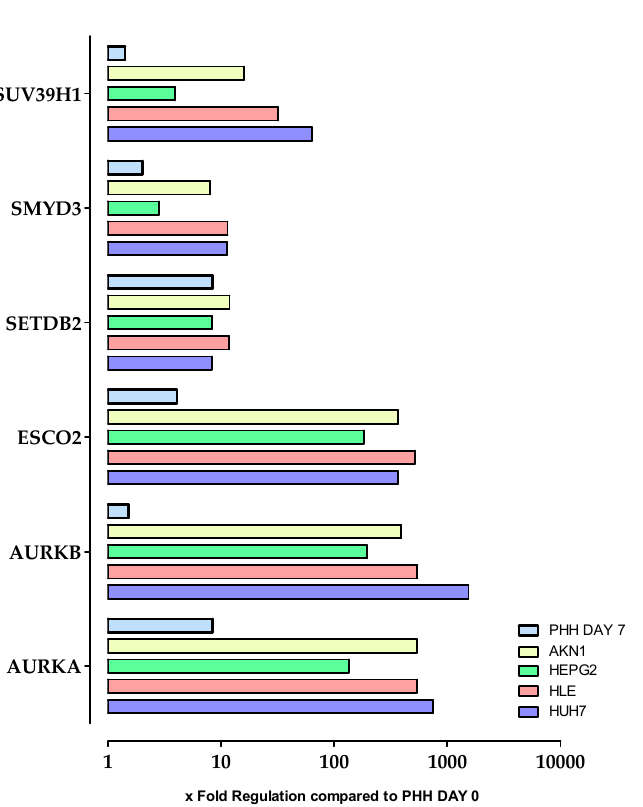
Figure 7. Chromatin modifying enzymes which are dramatically de-regulated in all tested cell lines and also de-regulated during primary human hepatocyte (PHH) de-differentiation in culture. Genes which are significantly de-regulated were selected. Expression of Chromatin Modification genes in hepatoma cell lines and PHH (day 7 after plating) were measured by using the Chromatin Modification Array.